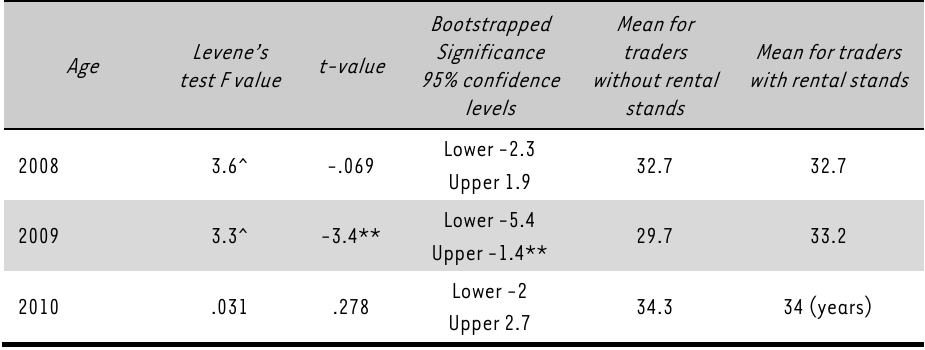
TABLE 7: Results of the t-tests for differences in Age